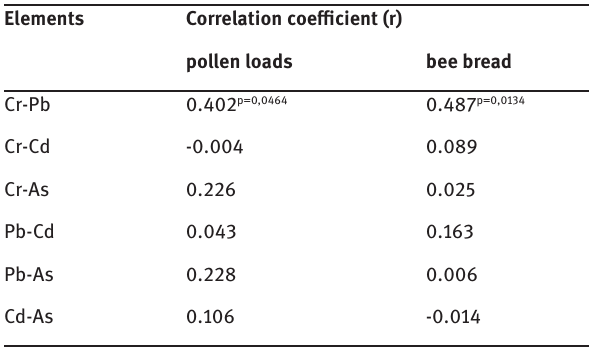
Table 4: Correlation coefficients (r) between element